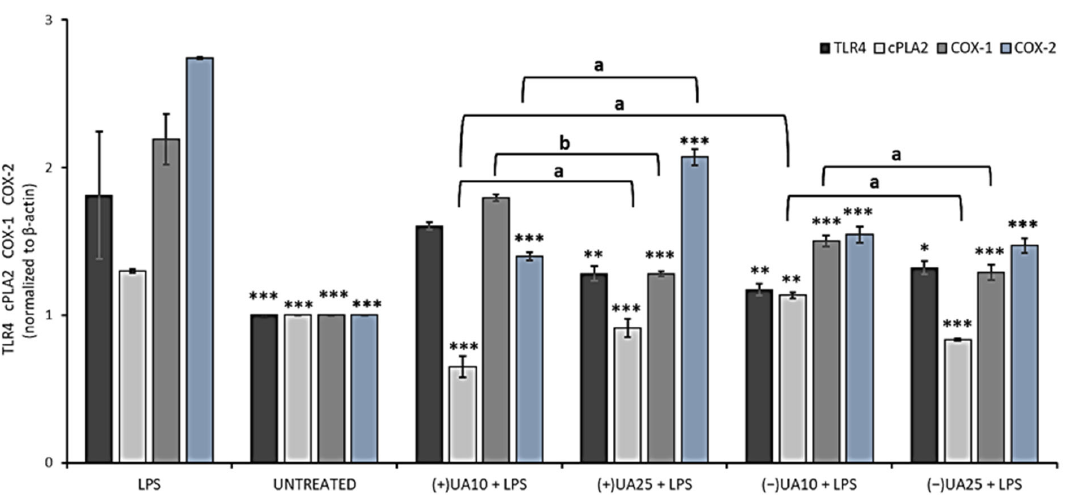
Figure 5. The effect of (+)- and ( − )-usnic acid on toll-like receptor 4 (TLR4), cytosolic phospholipase A2 (cPLA2), cyclooxygenase-1 (COX-1) and cyclooxygenase-2 (COX-2) release in LPS-stimulated RAW 264.7 macrophages. RAW cells were treated with 10 (UA10) and 25 (UA25) µ g/mL of usnic acid enantiomers and 10 ng/mL of LPS for 24 h. Control cells were not treated with the tested compounds nor LPS (untreated). Densitometric evaluation of the bands TLR4, cPLA2, COX-1, COX-2 from Western blots in relation to beta-actin is shown. Values are presented as the mean ± SD (standard deviation) of three independent experiments in triplicate. Statistical analyses were carried out by using one-way ANOVA and Tukey post-hoc test with * p < 0.05, ** p < 0.01 and *** p < 0.001 against the LPS-stimulated cells. Significant differences (a: p < 0.01 and b: p < 0.001) between usnic acid enantiomers and doses used in the experiment were marked by upper black line.